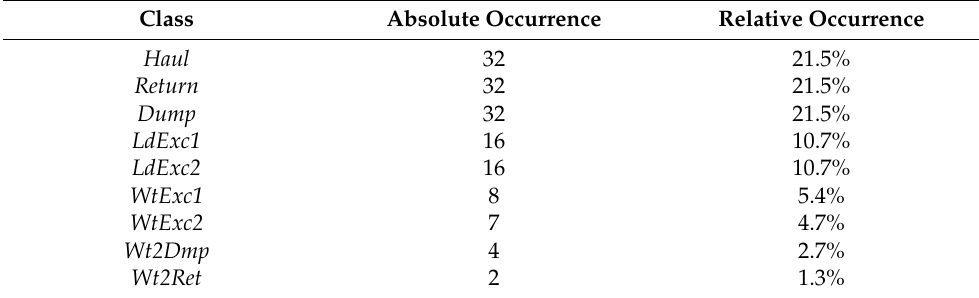
Table 1. Summary of the event classes with their absolute and relative occurrence.